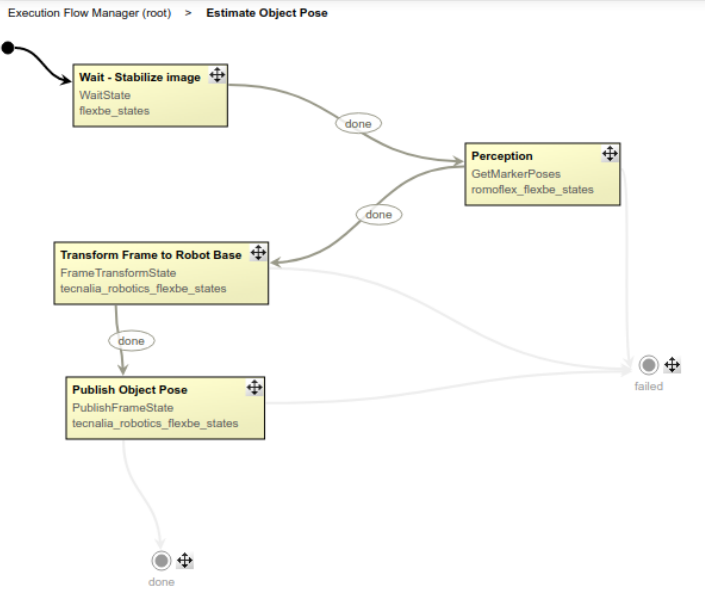
Figure 8. Estimate object pose skill is composed of additional operations that complement vision